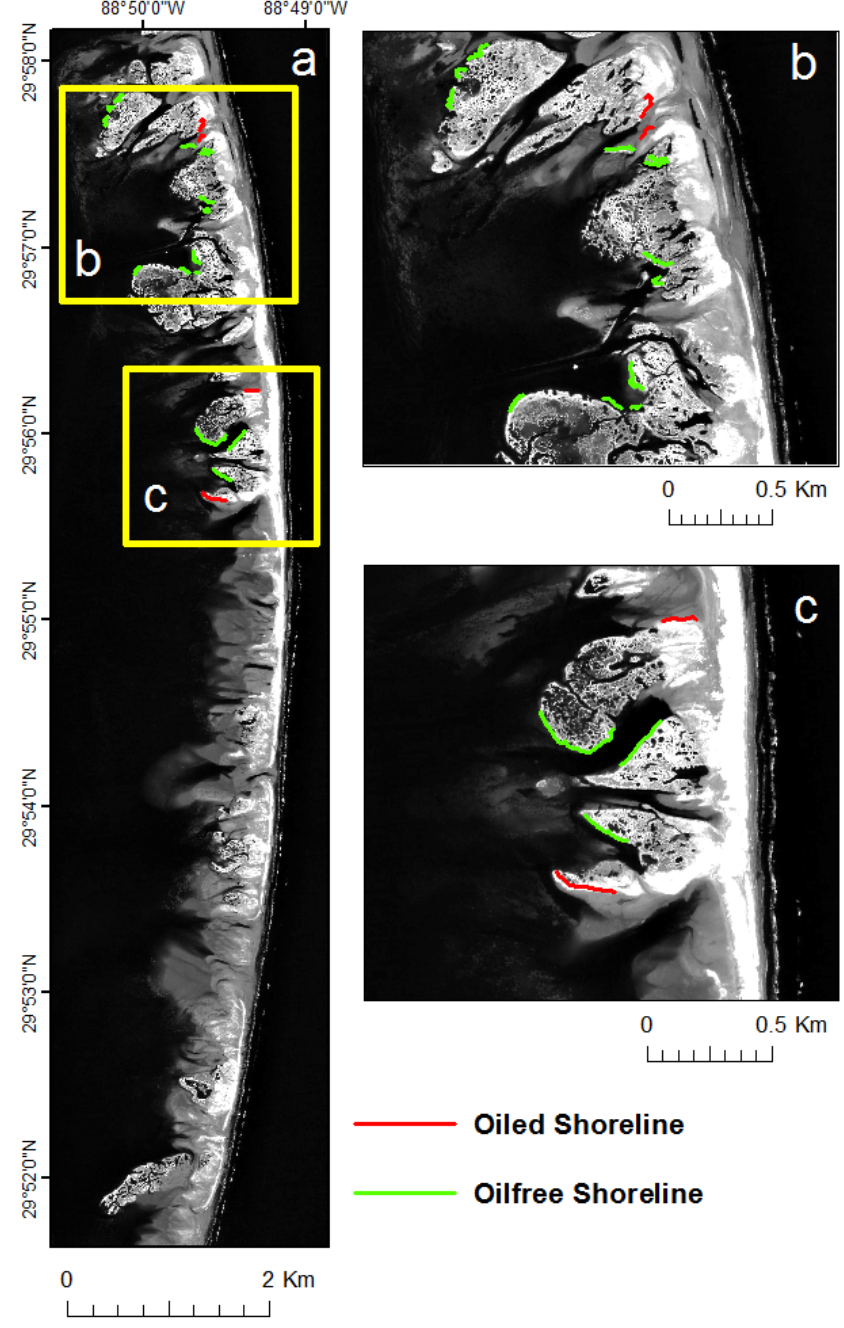
Figure 3. ( a ) SCAT oiled and oil-free shoreline data selected for analysis overlaid on the AVIRIS flightlines acquired over Chandeleur Islands on September 21, 2010 with detailed views of two sections, ( b ) and ( c ) affected by oiling.